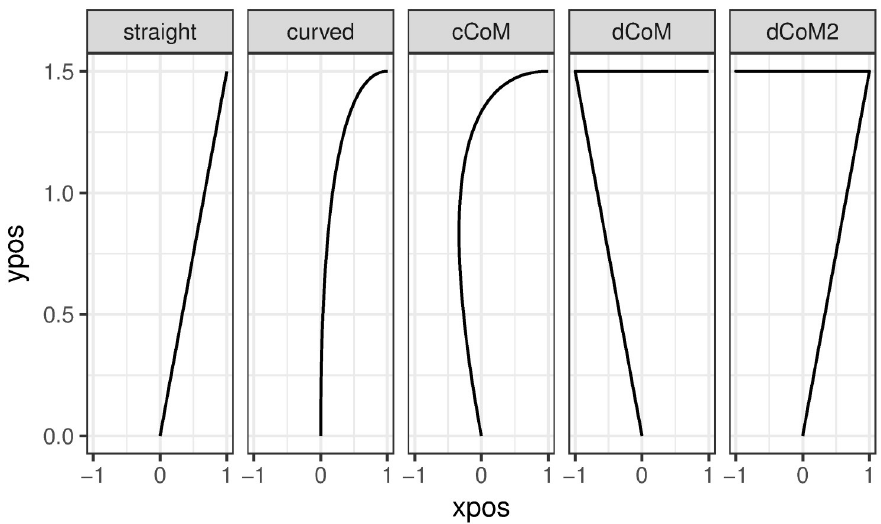
Fig 9. Trajectory prototypes. Straight, mildly curved, continuous change-of-mind, discrete change-of-mind, and double discrete change-of-mind.